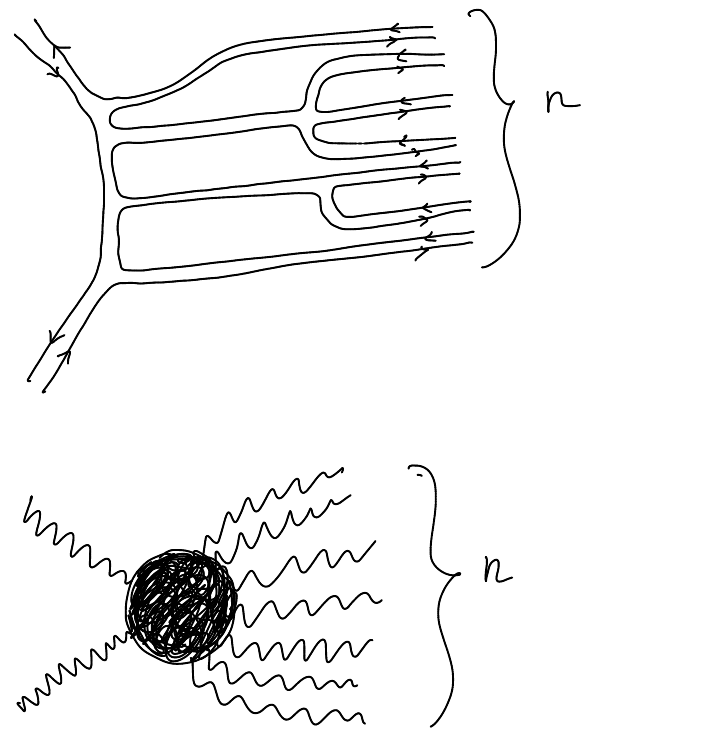
Figure 2 . A 2 → n process and an example of diagram in ’t Hooft double-line notation contributing in